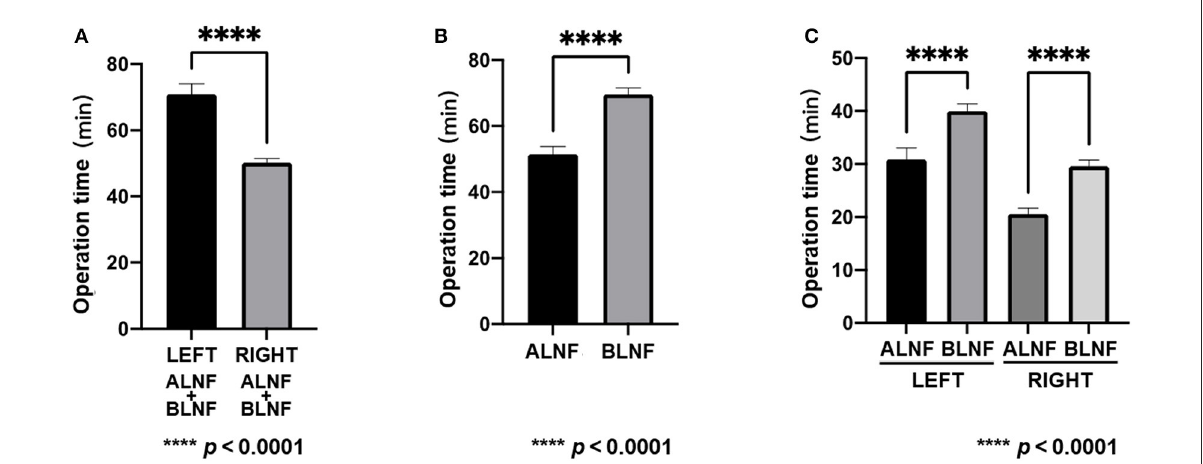
FIGURE3 Operation time. (A) Comparison of the total time for dissection of the right and left flaps. (B) Comparison of total dissection time of ALNF with that of BLNF. (C) Comparison of ALNF and BLNF on the same side. **** indicate the p-value between each group ( p < 0.0001).